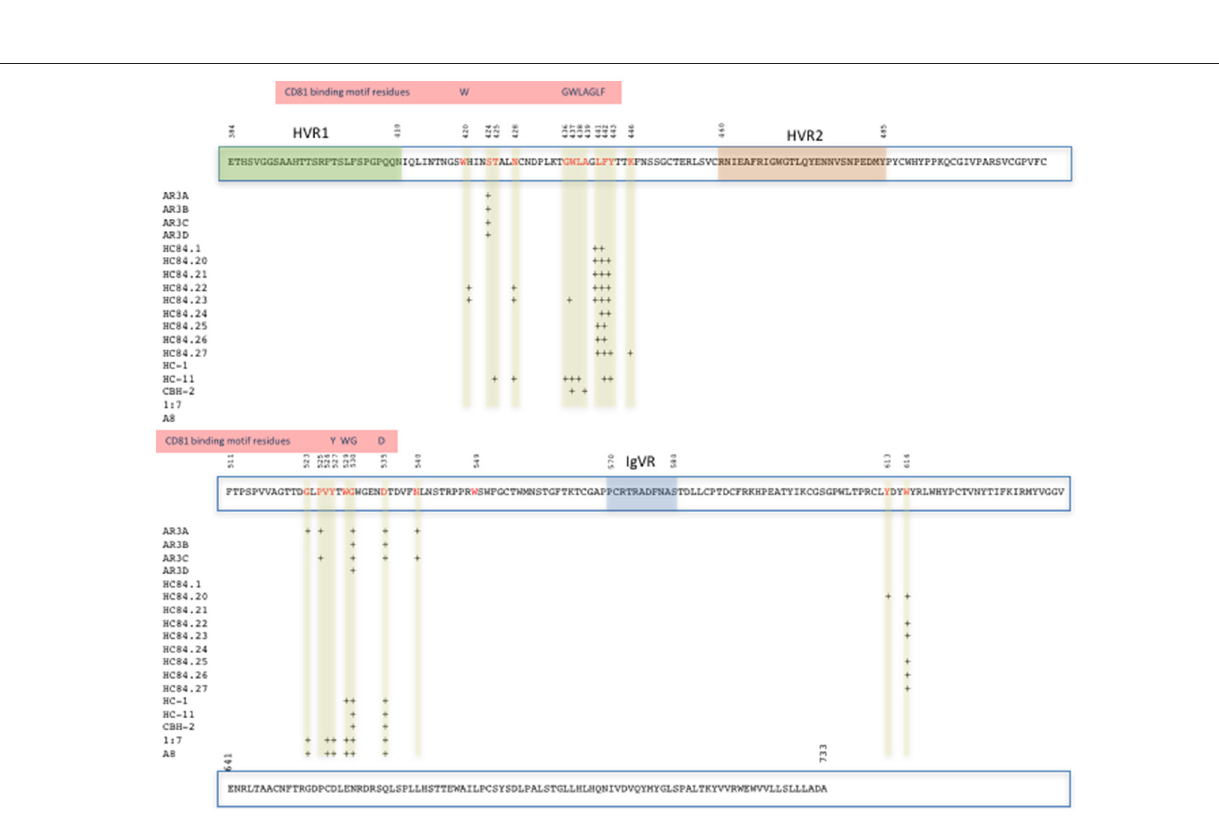
Frontiers in Microbiology |